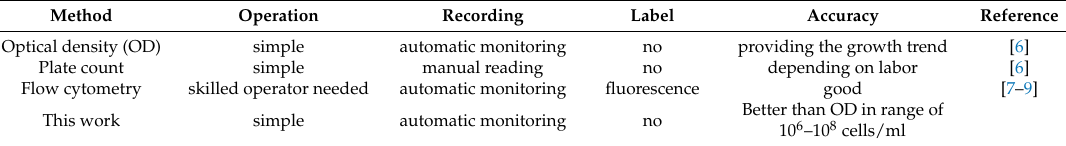
Table A1. The comparison of developed devices and this